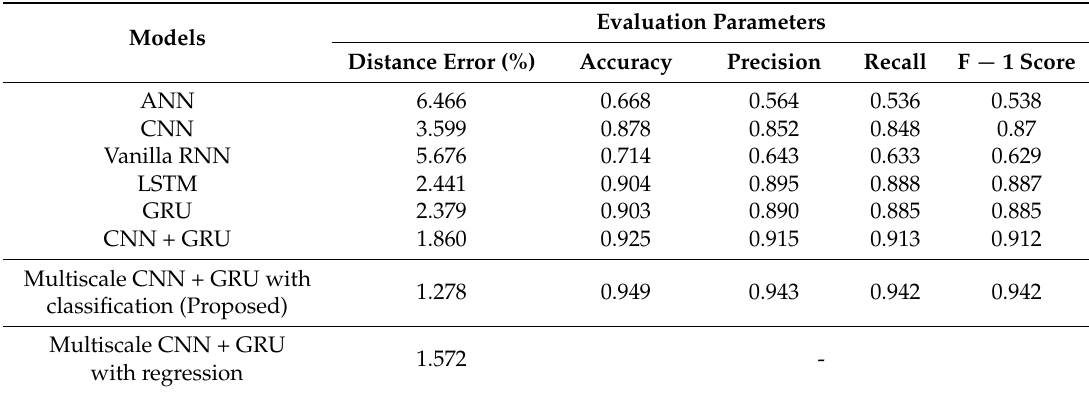
Table 3. Signal Classification Performance of the Proposed Model In Comparison with Other